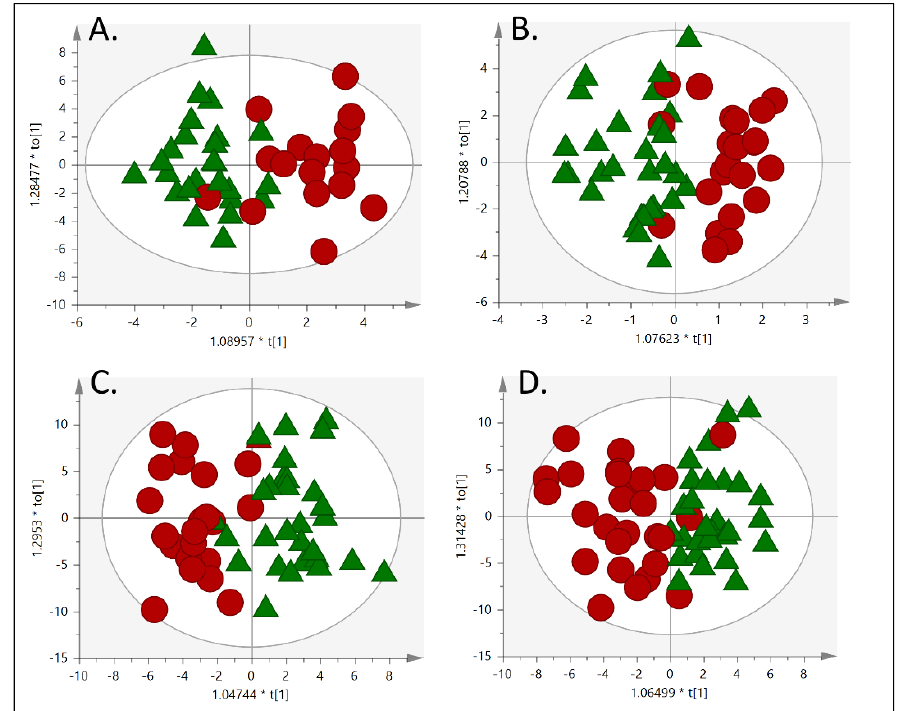
Figure 1. OPLS-DA scores plot ( A ) capillary electrophoresis-mass spectrometry, (R2 = 0.66, Q2 = Figure 1. OPLS ‐ DA scores plot ( A ) capillary electrophoresis ‐ mass spectrometry, (R2 = 0.66, Q2 = 0.2,